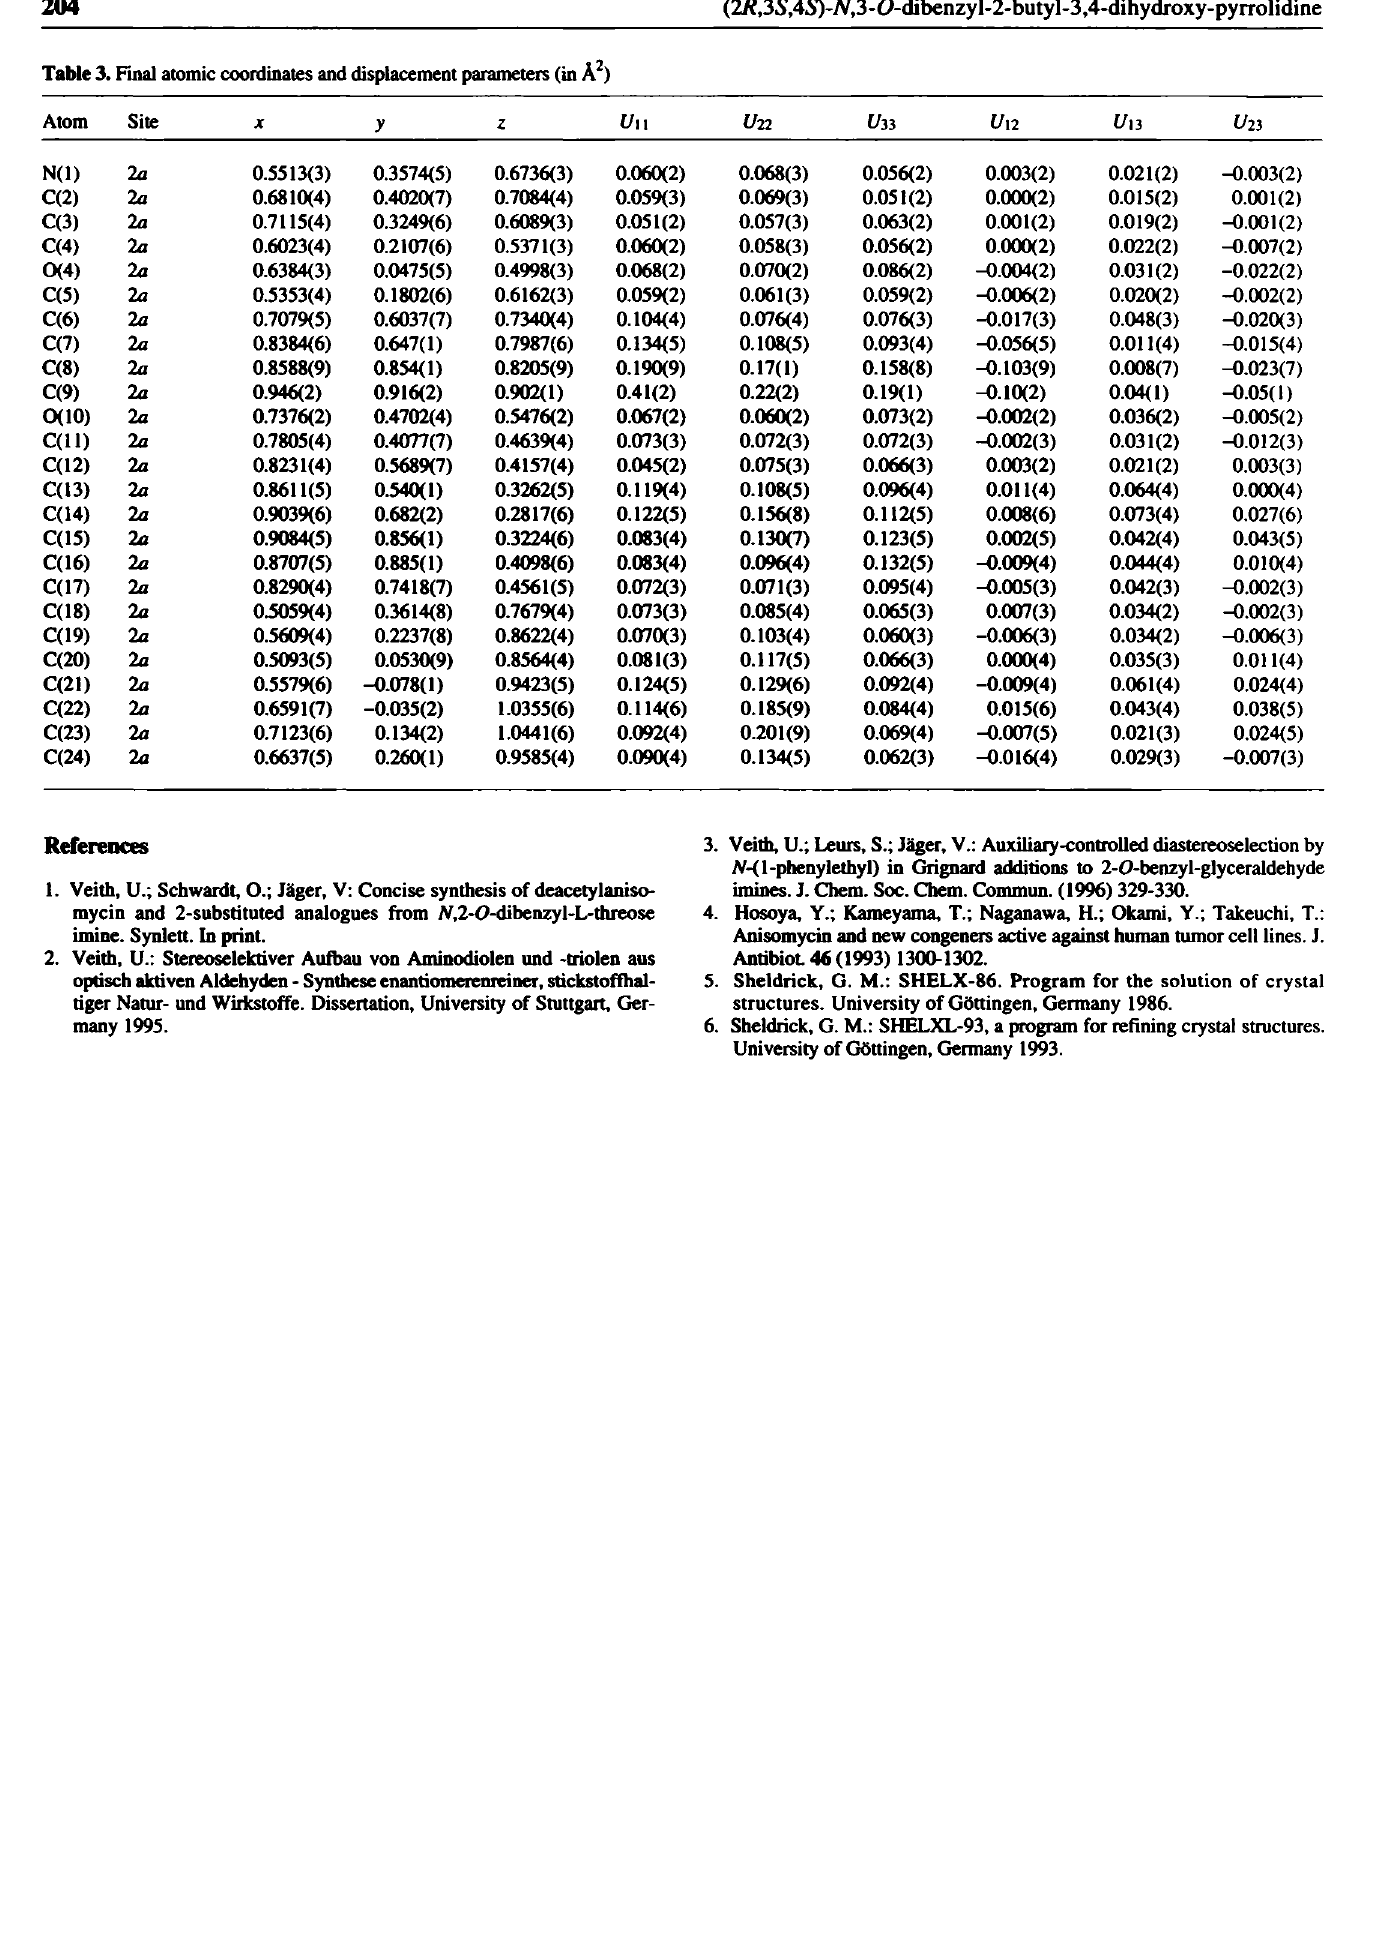
Table 3. Final atomic coordinates and displacement parameters (in Â 2